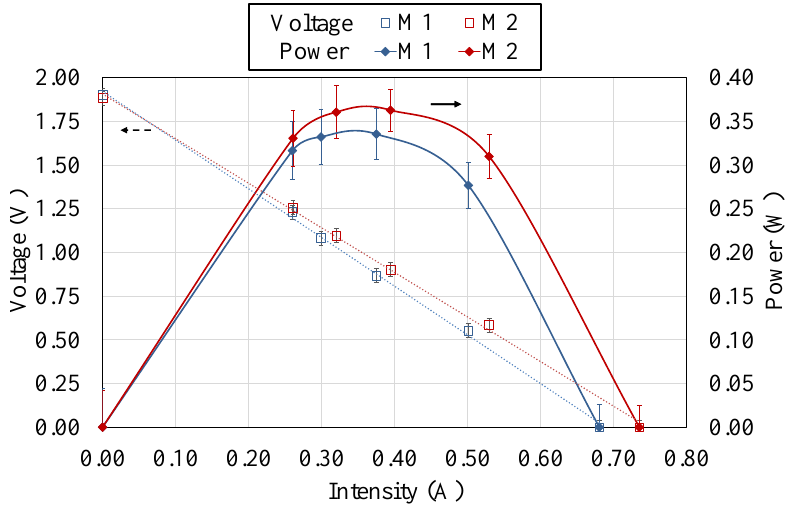
Figure 5. Voltage (left axis) and power generated (right axis) of the two thermoelectric modules studied, M1 and M2, with respect the intensity. The values correspond, from left to right, to open-circuit (OC), 4.7 Ω , 3.2 Ω , 2.2 Ω , 1 Ω and short-circuit